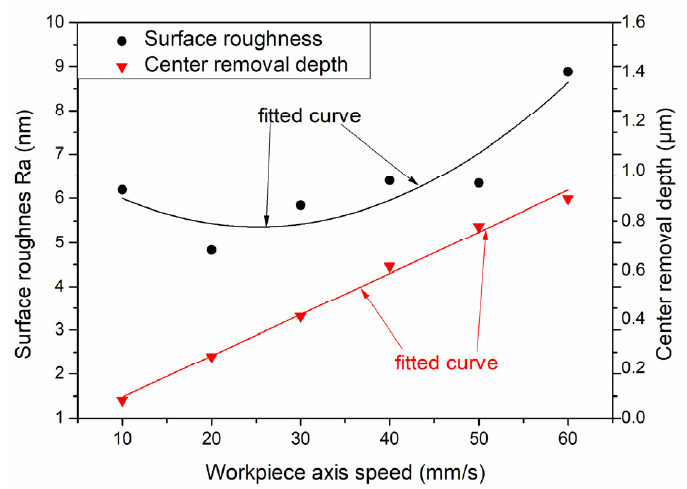
Figure 14. The relationship between SR and center removal depth with workpiece axis speed.